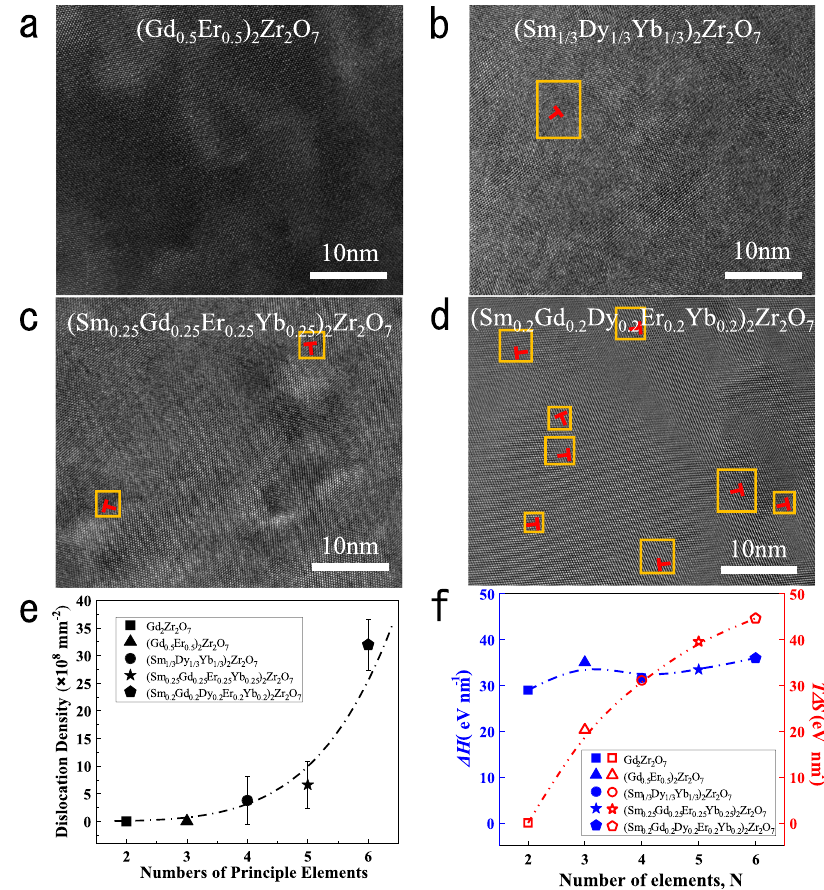
Fig. 3 High-resolution characterization and dislocation density of samples with different principle elements. a (Gd 0.5 Er 0.5 ) 2 Zr 2 O 7 ; b (Sm 1/3 Dy 1/3 Yb 1/3 ) 2 Zr 2 O 7 ; c (Sm 0.25 Gd 0.25 Er 0.25 Yb 0.25 ) 2 Zr 2 O 7 ; d (Sm 0.2 Gd 0.2 Dy 0.2 Er 0.2 Yb 0.2 ) 2 Zr 2 O 7 ; e Dislocation density varies with numbers of principle elements (The error bars represent the standard deviation of calculated dislocation density.); f Enthalpy change (blue line and symbols) of an edge dislocation compared with the entropy gain “ T Δ S ” (red line and symbols) with increasing number of the principle elements. The yellow squares mark the area around the